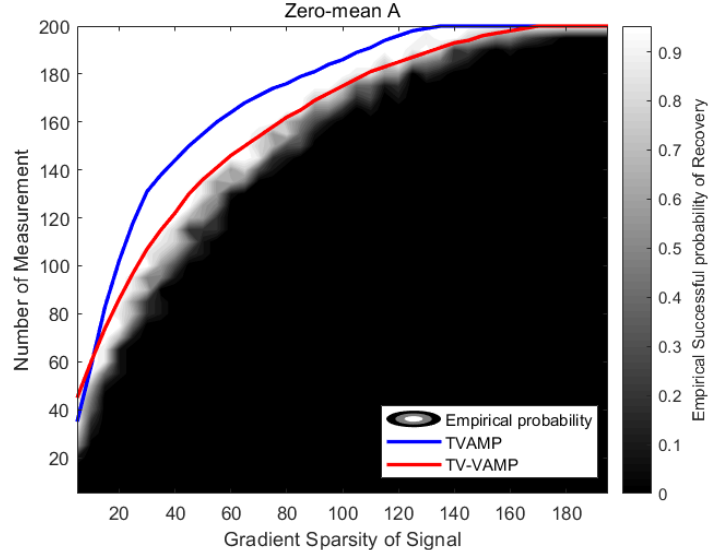
Figure 4. The figure shows phase transitions of CVX, TVAMP algorithm, and TV-VAMP algorithm when A is a zero-mean Gaussian distribution measurements matrix and n =